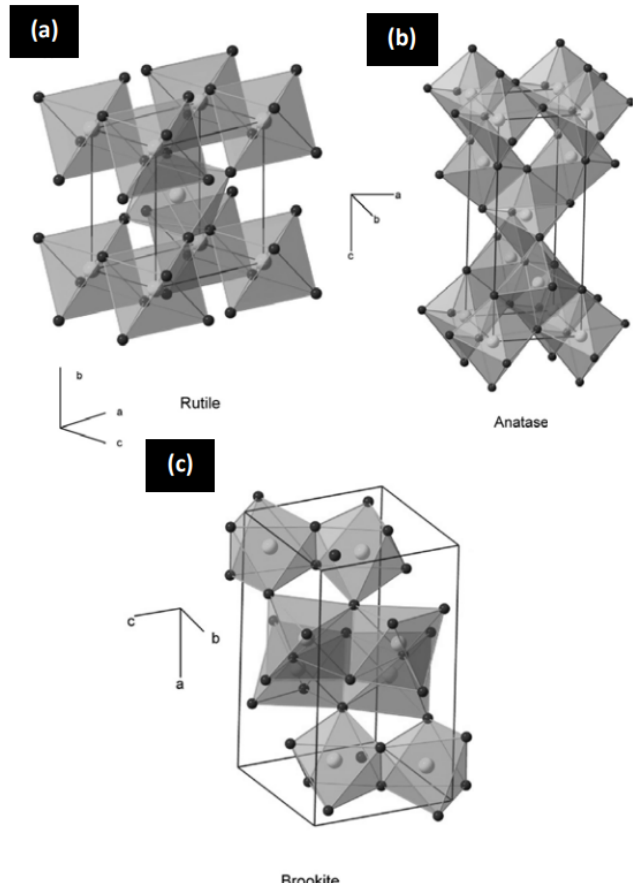
Figure 1. Crystal structure of TiO 2 : ( a ) rutile ( b ) anatase and ( c ) brookite. Adapted with permission from Ref. [17]. Copyright 2009, Elsevier.